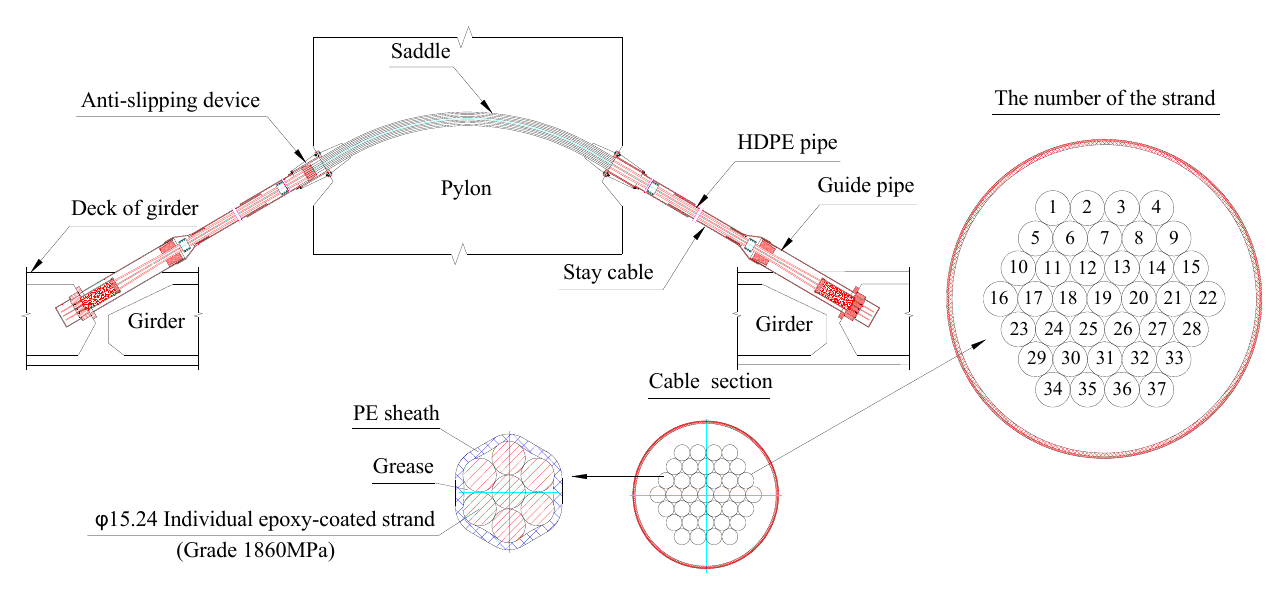
Figure 1. The structure of the stay